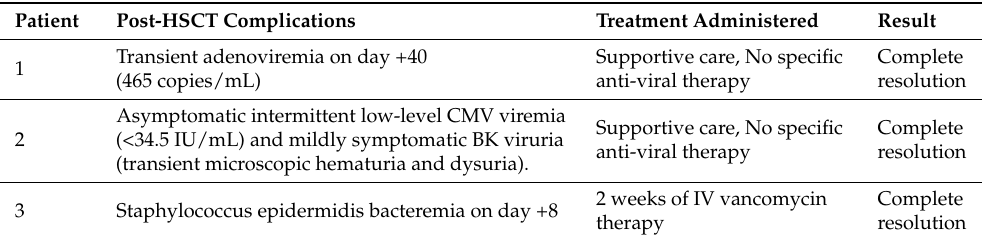
Table 2. Post-transplantation complications are summarized below including infections and subse- quent management. All post-HSCT infections resolved.